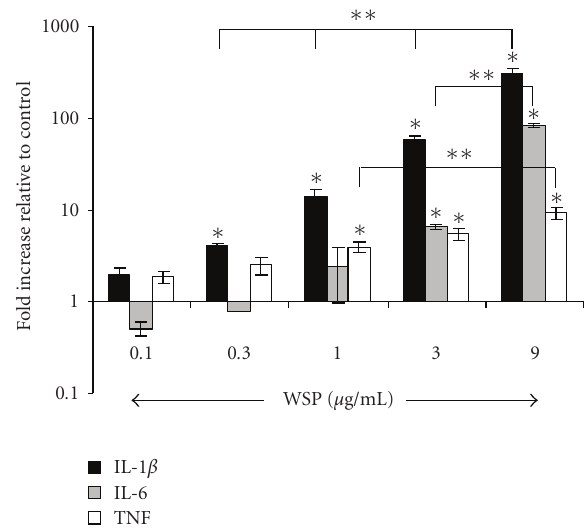
Figure 1: Dose response of rWSP-induced IL-1 β , IL-6, and TNF mRNAs production in murine macrophage RAW 264.7 cells. The macrophage cells were incubated with various concentrations of rWSP for 3 hours. The data represent mean values and standard deviations of fold increase of cytokine transcripts relative to nega- tive control in log scale. Significant di ff erences to untreated controls ( ∗ P < . 01 for IL-1 β mRNA levels and P < . 05 for IL-6 and TNF mRNA levels) and to rWSP-stimulated cells at 9 μ g/mL ( ∗∗ P < . 05) are